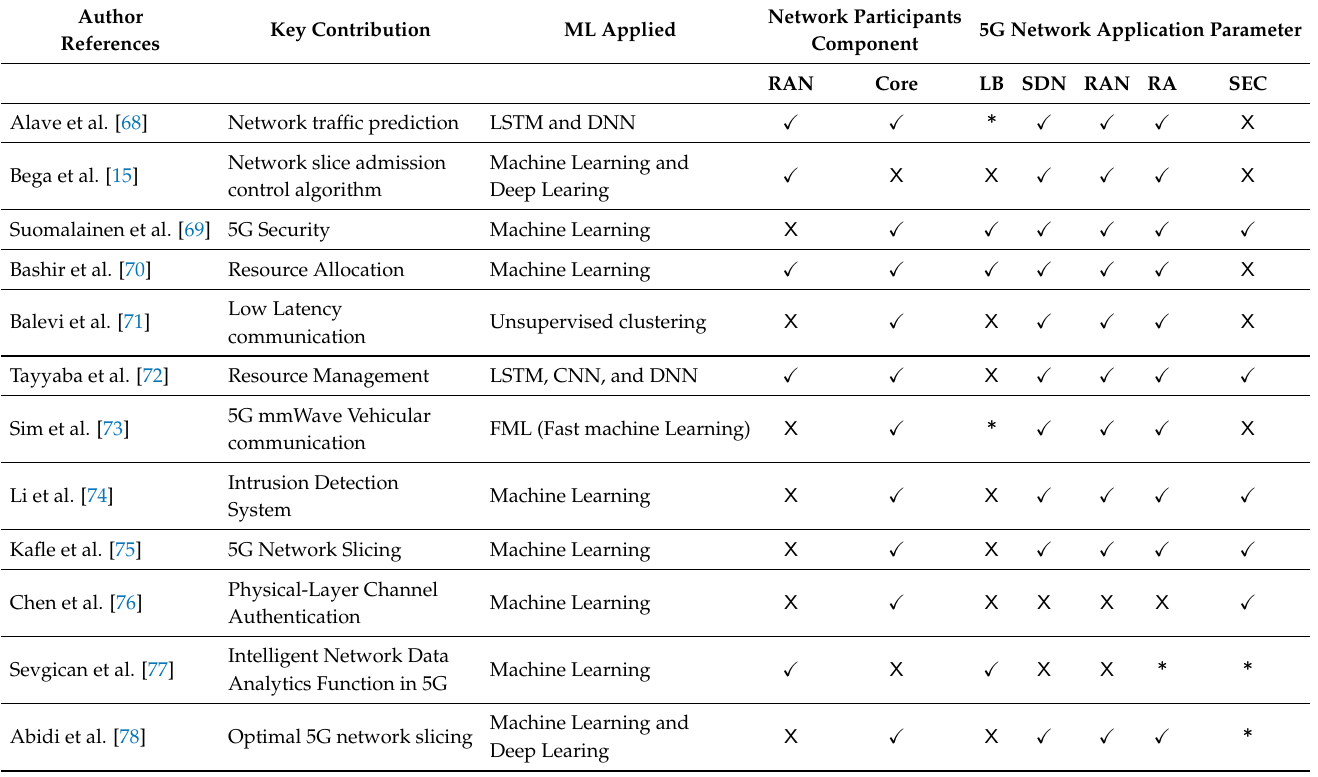
Table 9. The state-of-the-art ML-based solution for 5G